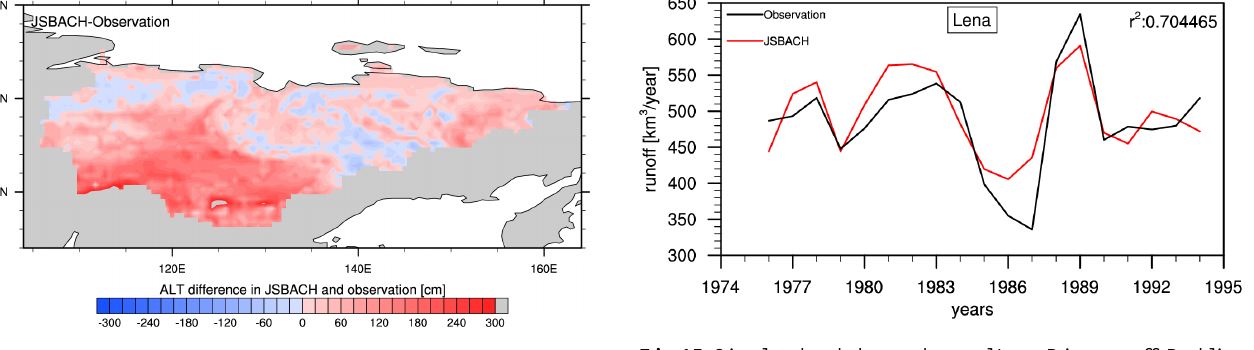
Fig. 14. Difference of simulated and observed active-layer thickness-ALT (map b − a from Fig. 13).